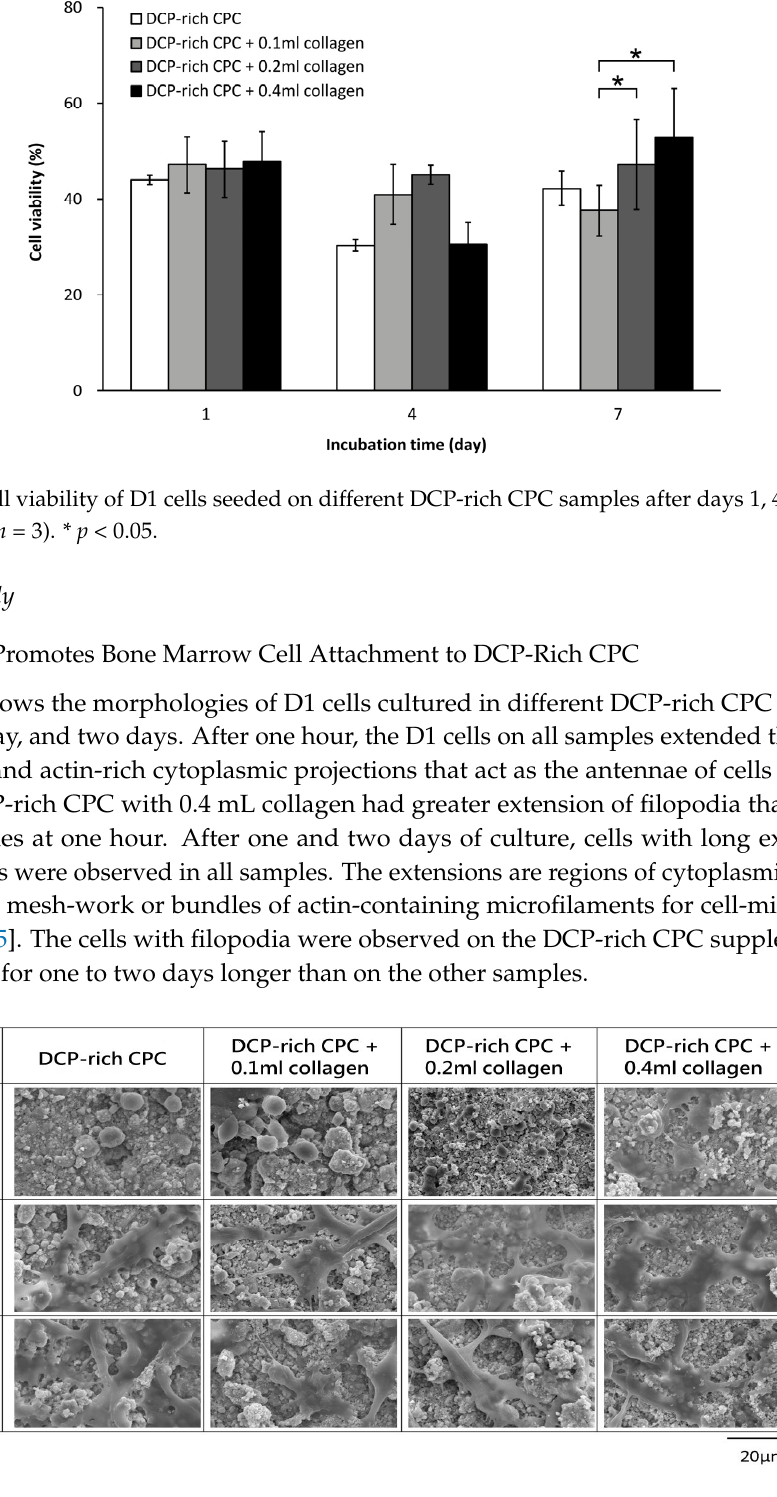
Figure 2. Typical morphologies of different DCP-rich CPC samples with fixed D1 cells, as evaluated by SEM.